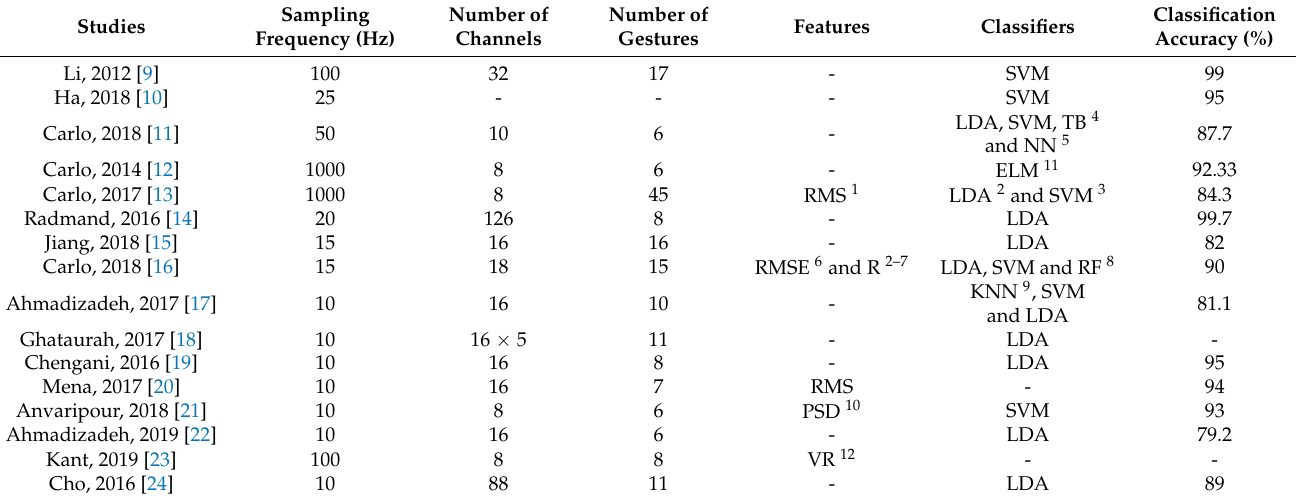
Table 1. Sampling rates and number of sampling channels in the